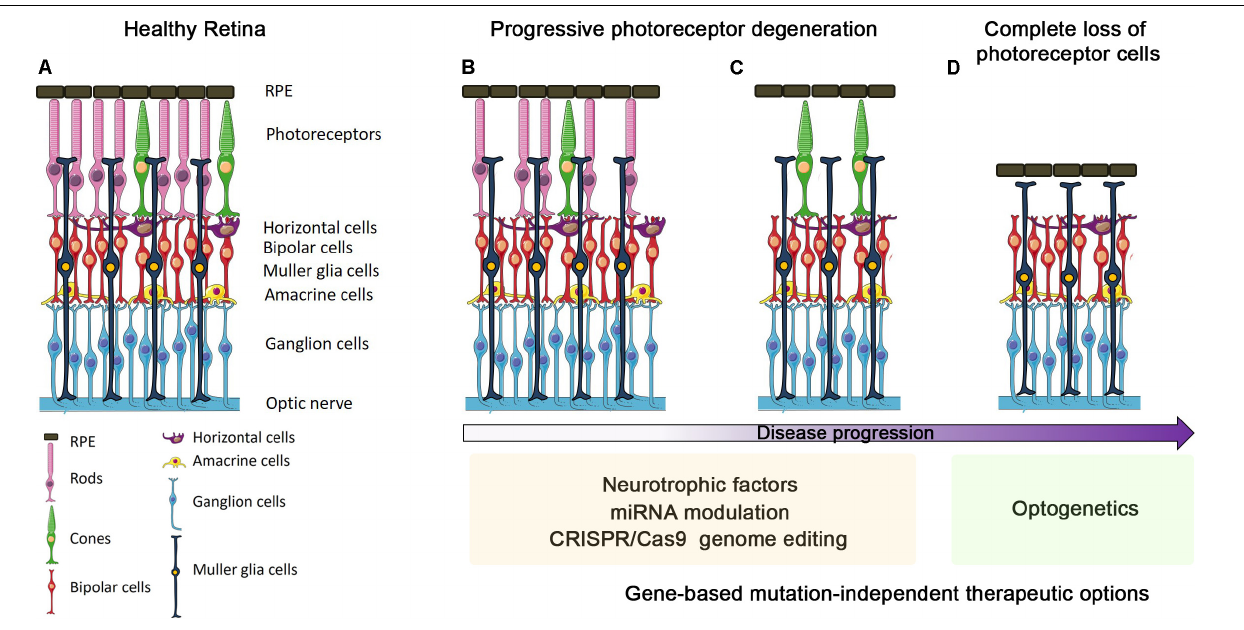
FIGURE 1 | Progression of outer retinal degenerative disease and gene-based mutation-independent therapy options. Schematic representation of either retinas in healthy conditions (A) or undergoing different stages of degeneration progression (B–D) . The ongoing photoreceptor degeneration (B) and before the progressive cone degeneration (C) stages can benefit from the use of neurotrophic factors, miRNA modulation and CRISPR/Cas9 genome editing. In the final stage, i.e., when all photoreceptors are lost (D) , optogenetics seems to be the only suitable gene-based mutation-independent therapy